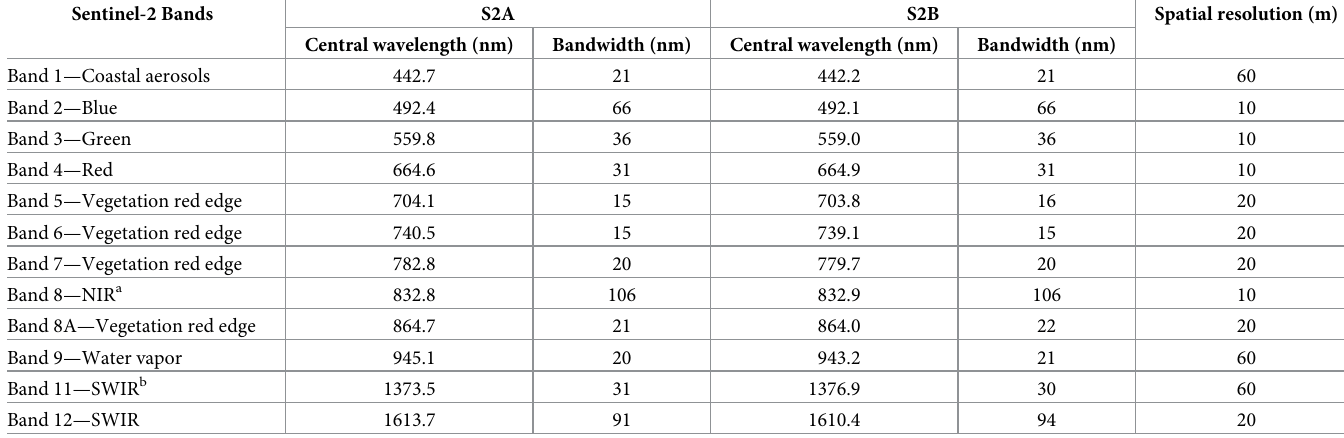
Table 1. Spectral bands of the Sentinel-2 sensors (Sentinel-2A and Sentinel-2B).